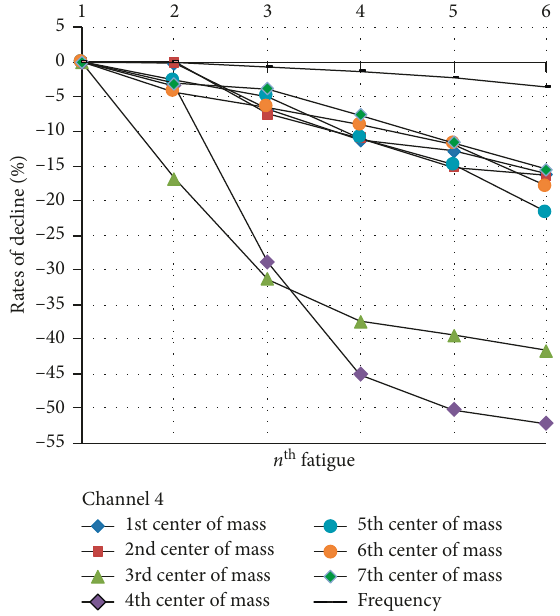
Figure 23: The declined rates in channels 4 with 7 central points in 4 fatigue